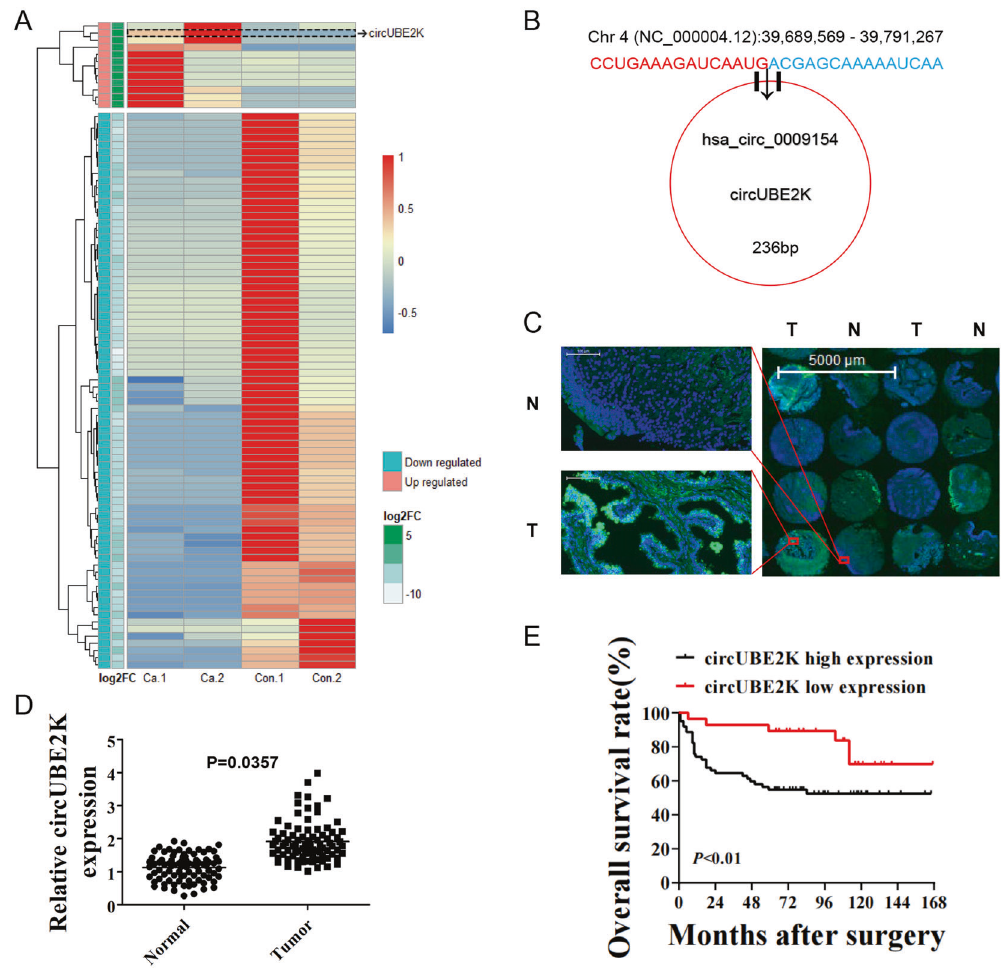
Fig. 1 Expression of circUBE2K was upregulated in BC and was related to bladder cancer prognosis. A Heatmap illustrated normalized expression patterns of 90 differentially expressed circRNAs between two BC tissues and their paired adjacent normal tissues ( P -value < 0.05 and |log2FC > 2). Each column represents one sample. Expression of circUBE2K was highlighted with a dashed frame. B The genomic location and illustration of has-circ-0009154. C Fluorescent in situ hybridization (FISH) for circUBE2K (Green) and DAPI (Blue) in 90 pairs of bladder cancer tissue microarray. circUBE2K is up regulated in BC tissue (Right panel) comparing to paired normal tissues (Left panel). Also, circUBE2K locates in BC cell cytoplasm. Representative area was selected. D Relative expression of circUBE2K in BC was higher than normal tissues ( P < 0.05 versus normal tissue). E Kaplan-Meier plot for BC patients ’ overall survival (OS), based on FISH circUBE2K expression level ( n = 90; P < 0.01, Log rank